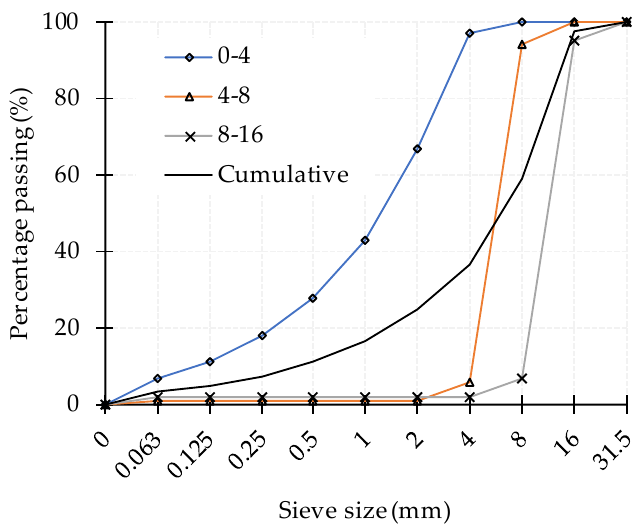
Figure 3. Aggregate grading curves.